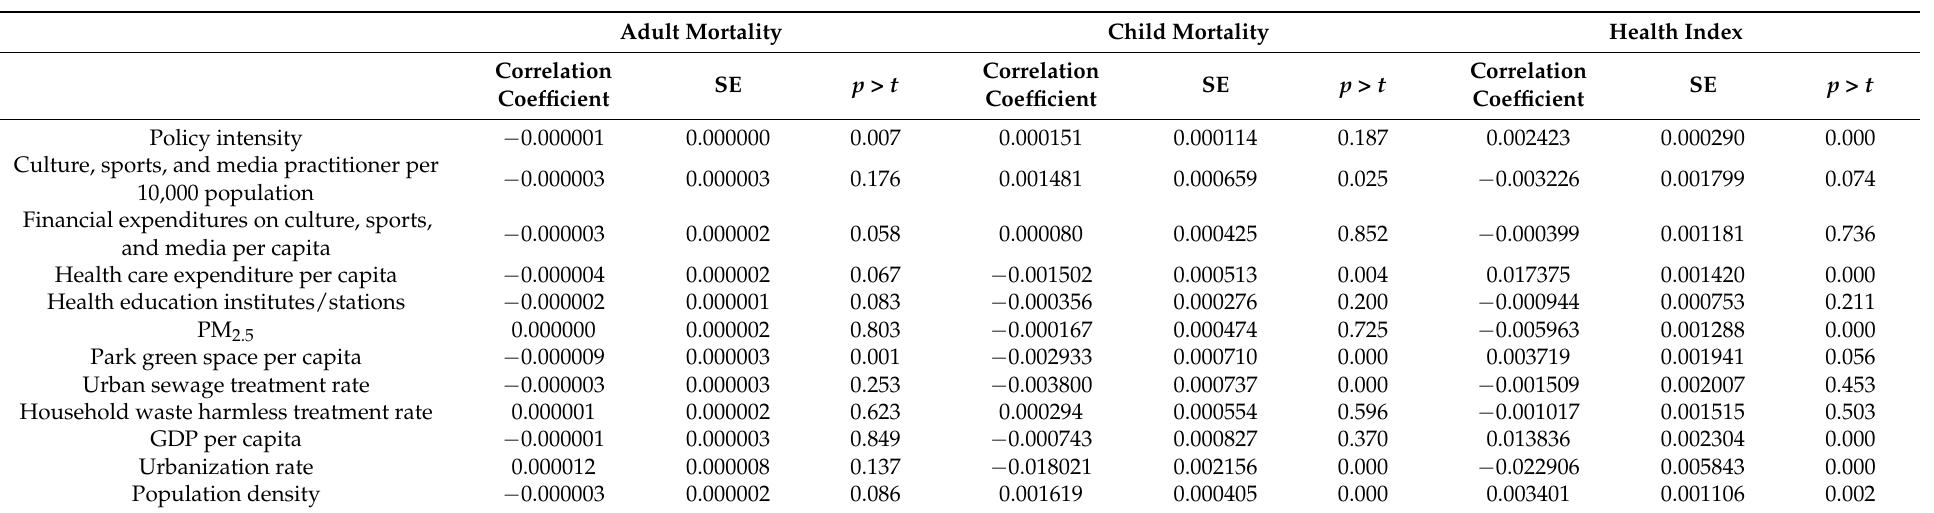
Table 6. Regression results of robustness